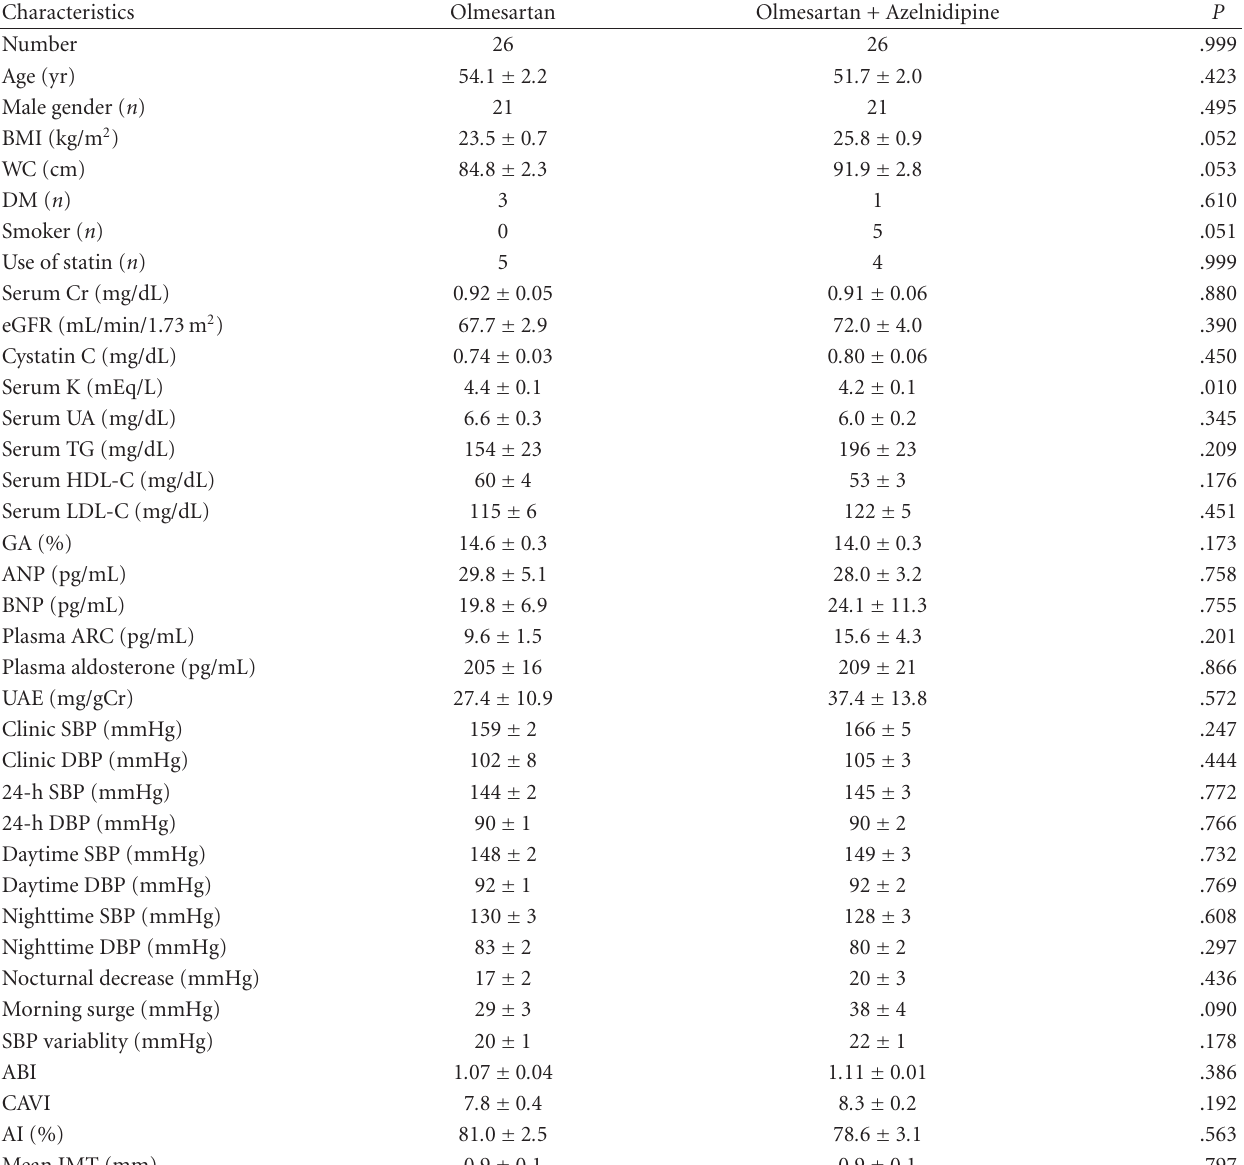
Table 1: Patient characteristics at